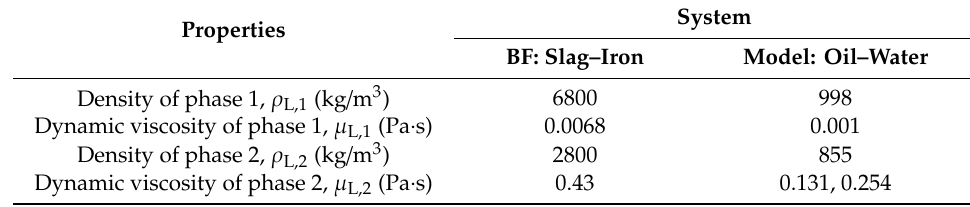
Figure 2. Schematic illustration of the experimental setup. Table 1. Physical properties of fluids for the blast furnace (BF) and model system.